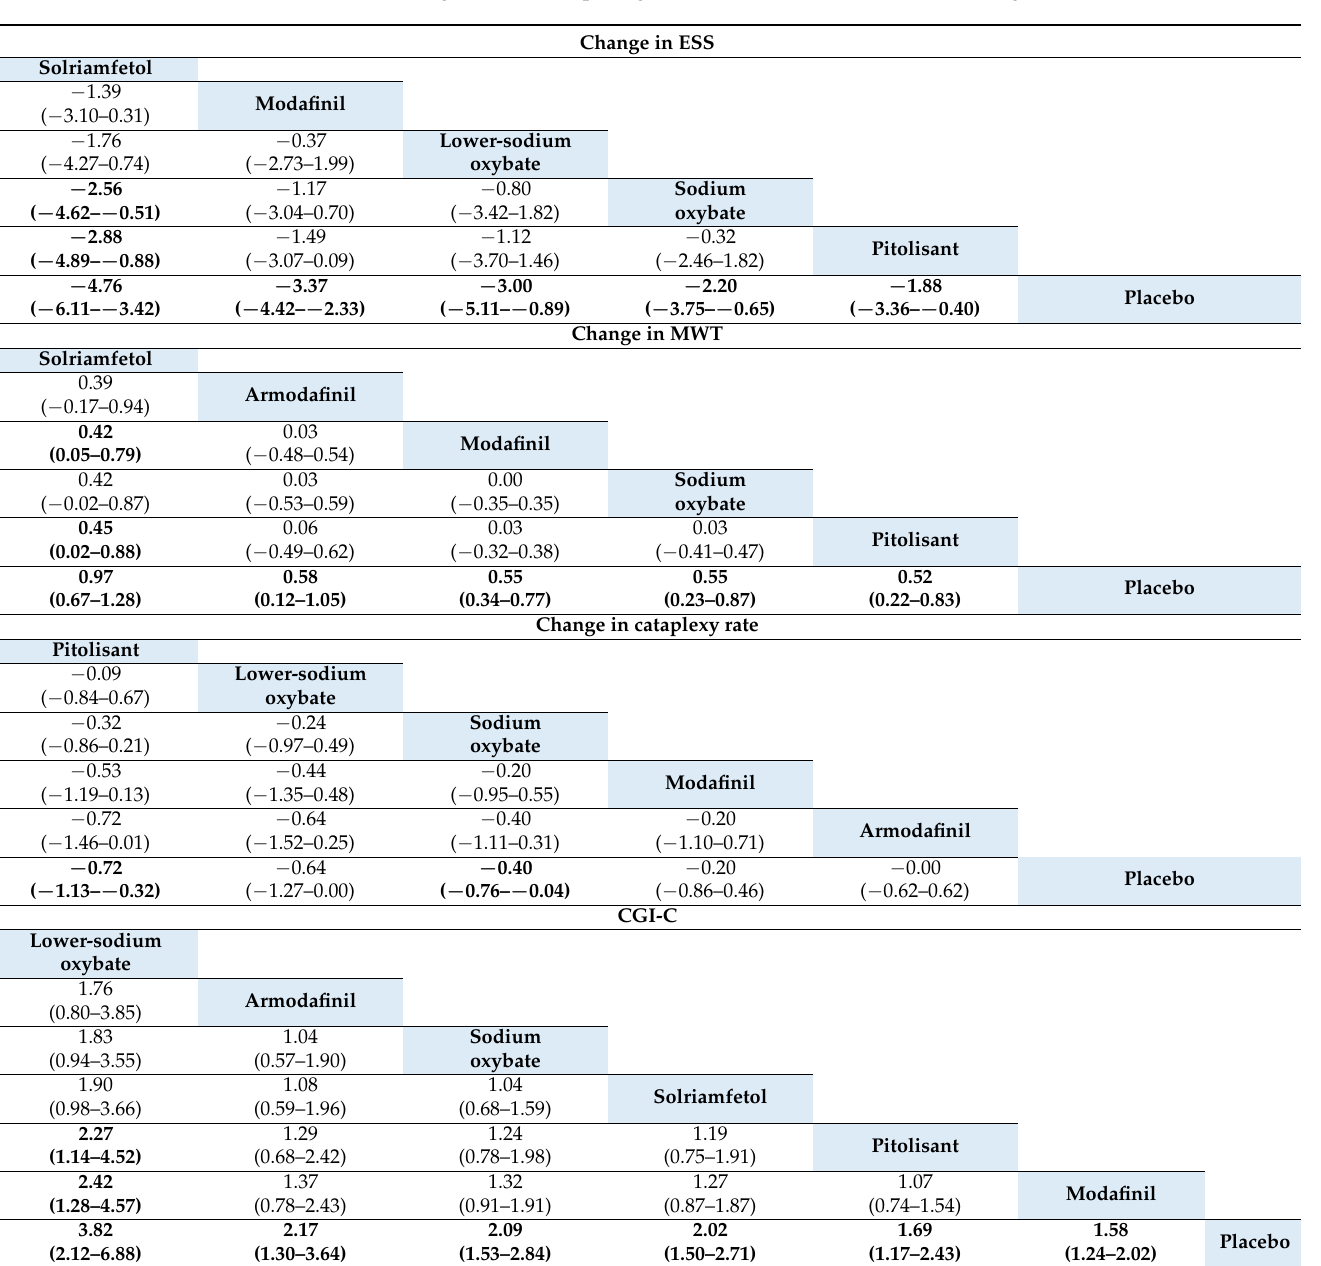
Table 1. League tables comparing estimated treatment effects combining direct and indirect